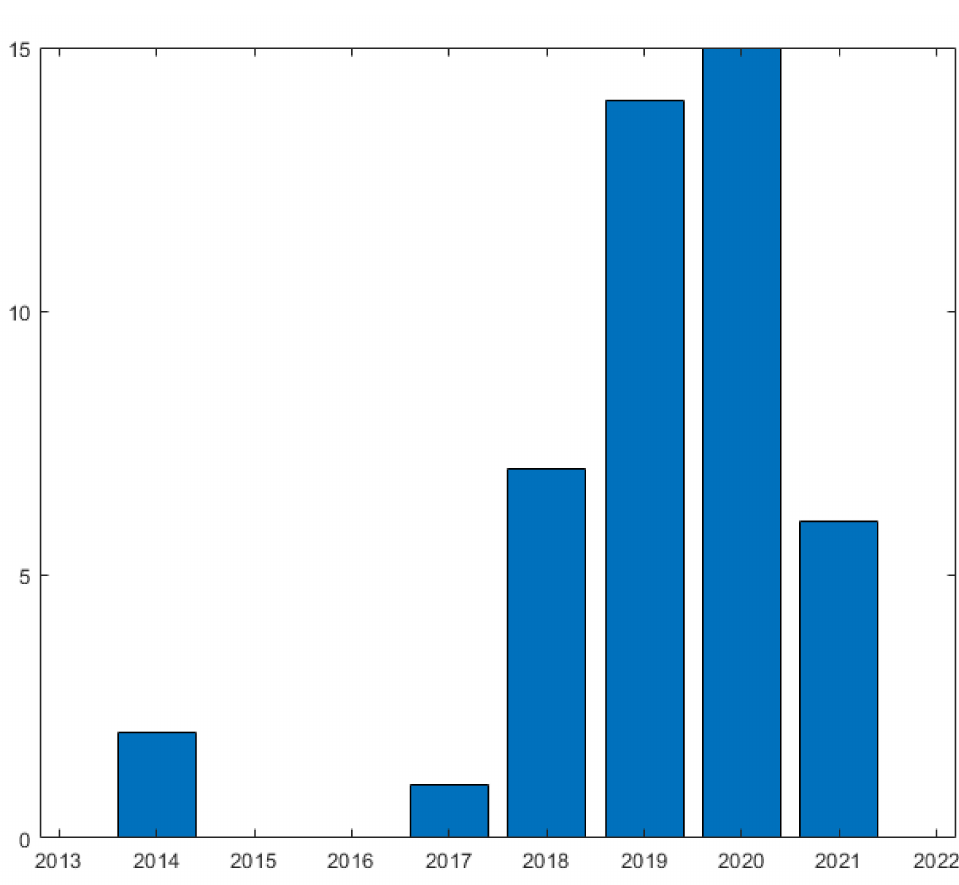
Figure 5. Bar chart presenting the total times “LEC” was used as a keyword in the existing bibliogra-